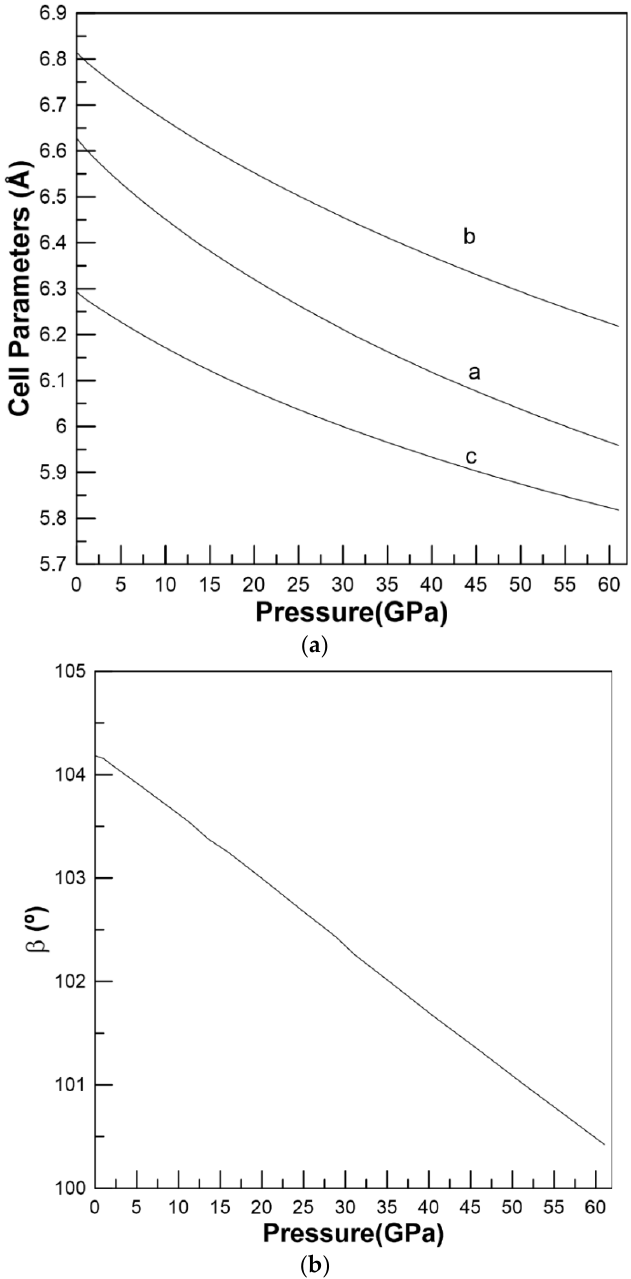
Figure 2. ( a ) Pressure dependence of the lattice parameters. ( b ) Pressure dependence of the β angle.